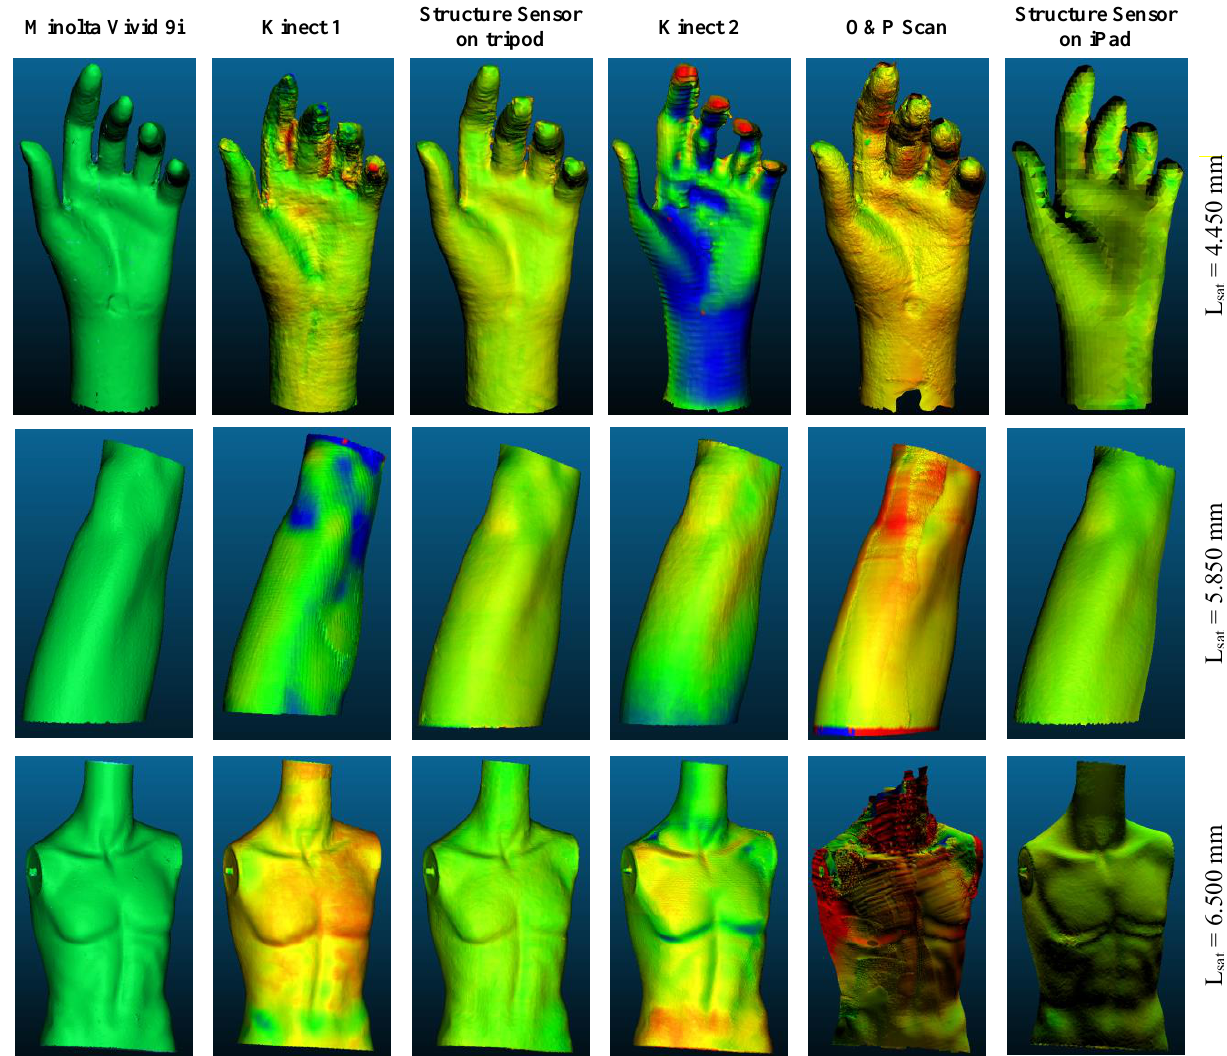
Figure 3. Results obtained by the different devices, organized by column, acquiring the three anatomical objects, organized by row. The models acquired with Minolta, first column, were used as reference in the comparison of all the other devices. The colour scale is the same gradual one depicted in the first column of Figure 2 and it has been set to be the same in the row with the limits for saturation indicated by the value L sat on the right side, different for each